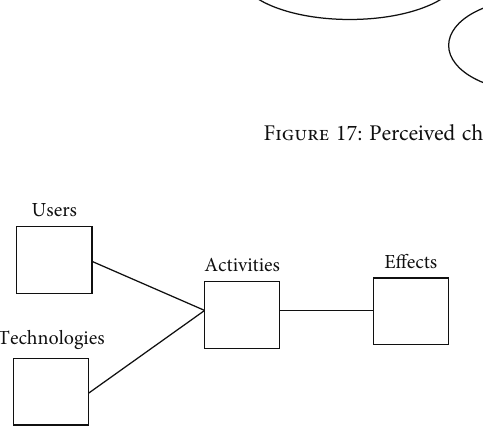
Figure 18: The basic model of human behavior with technologies